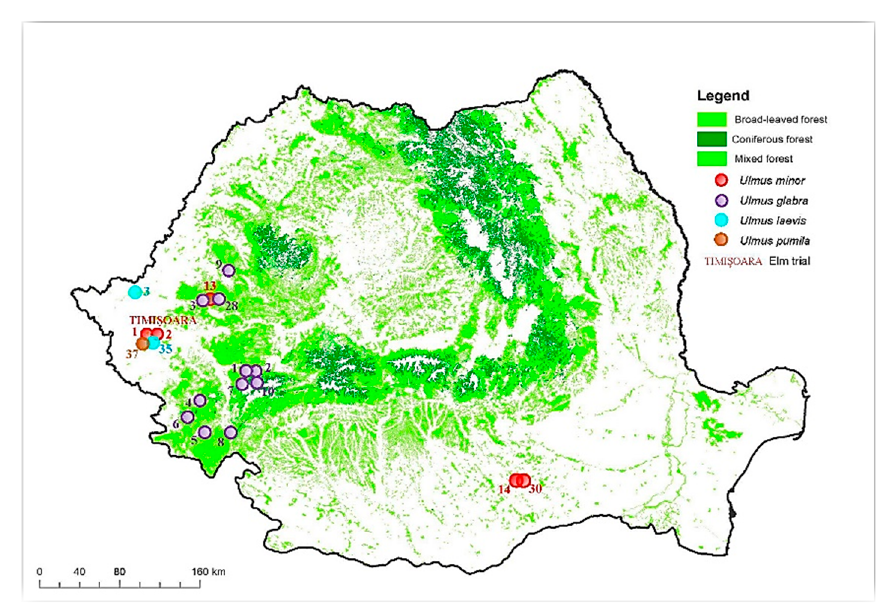
Figure 1. Elm provenances tested in the P ă durea Verde trial, Timi ș oara (based on CORINE Land Cover 2018 [45]).